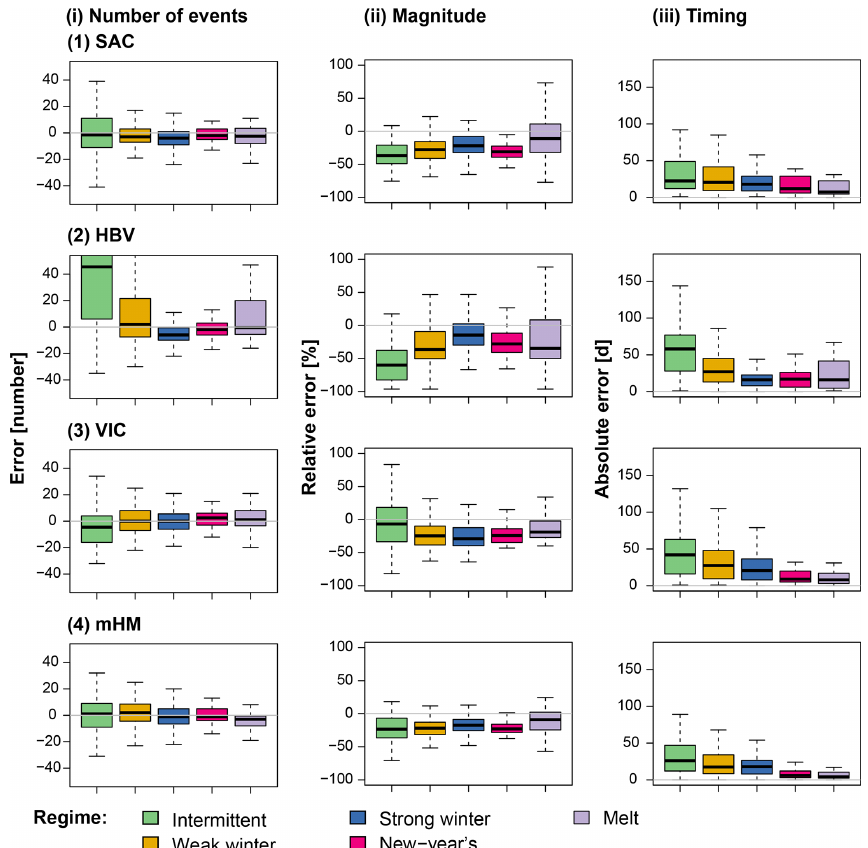
Figure 3. Model errors per regime type computed over the period 1981–2008: intermittent (114 catchments), weak winter (108), strong winter (176), New Year’s (50), and melt (40) (Fig. 1). Errors are shown for (i) number of events (error in number of events), (ii) magnitude (mean relative error), and (iii) timing (mean absolute error in days) for the four models (1) SAC, (2) HBV, (3) VIC, and (4) mHM. The boxplots are composed of one value per catchment belonging to the respective regime